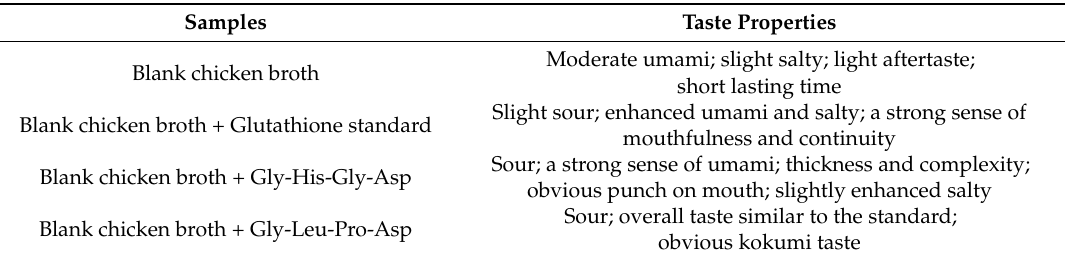
Table 3. Sensory evaluation of peptides by solid phase synthesis in chicken broth.